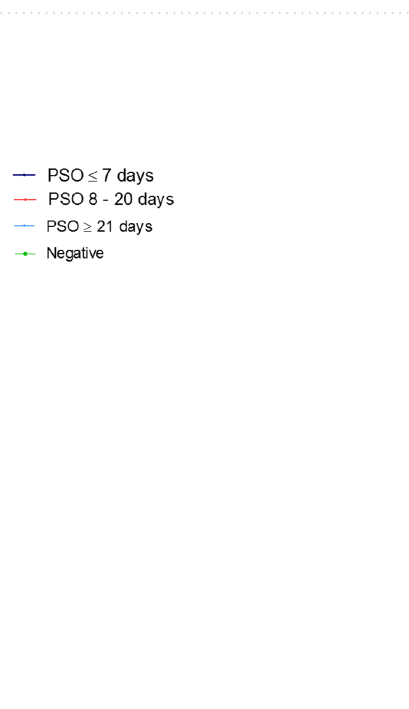
serum samples against rSARS-CoV-2 Prok1-S1 protein was demonstrated in a stratified manner according to PSO of ≤ 7 days, 8 to 20 days and ≥ 21 days (Fig. 4). All positive samples are paired and collected on the same